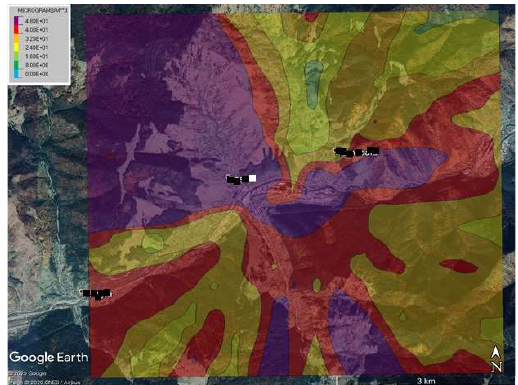
Energies 2022 , 15 , x FOR PEER REVIEW Figure 15. Hourly NOx concentration in the area of interest—Google Earth Pro . Figure 15. Hourly NOx concentration in the area of interest—Google Earth Pro.